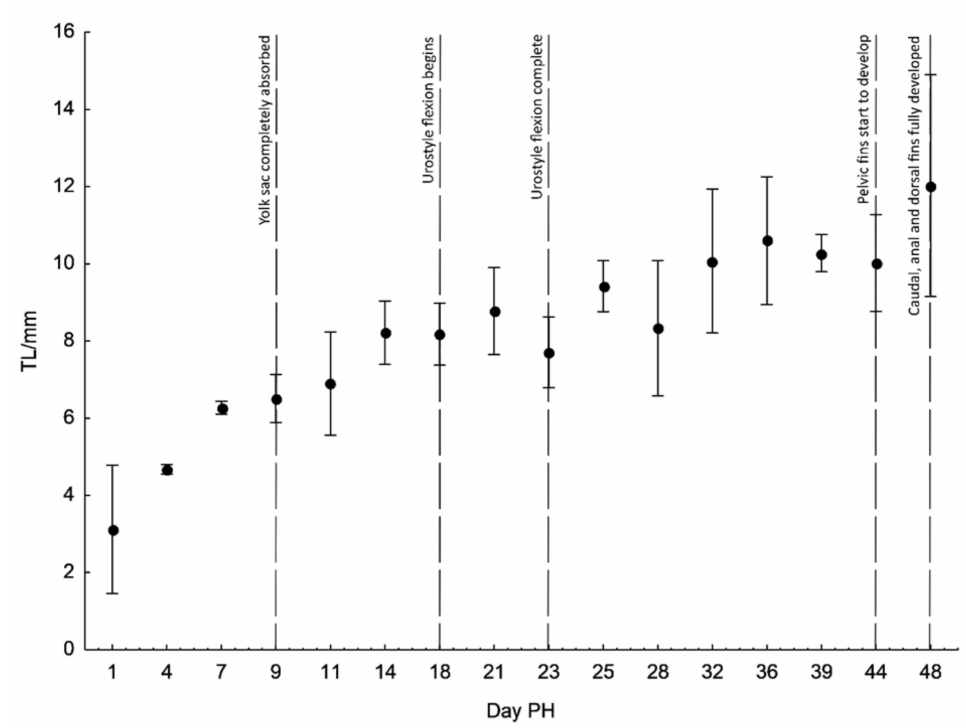
Figure 3. Changes in total length (TL) of D. krbavensis during the early stages of development (from hatching to day 48 post-hatching (PH)) at 17 ◦ C. Bars indicated SD (standard